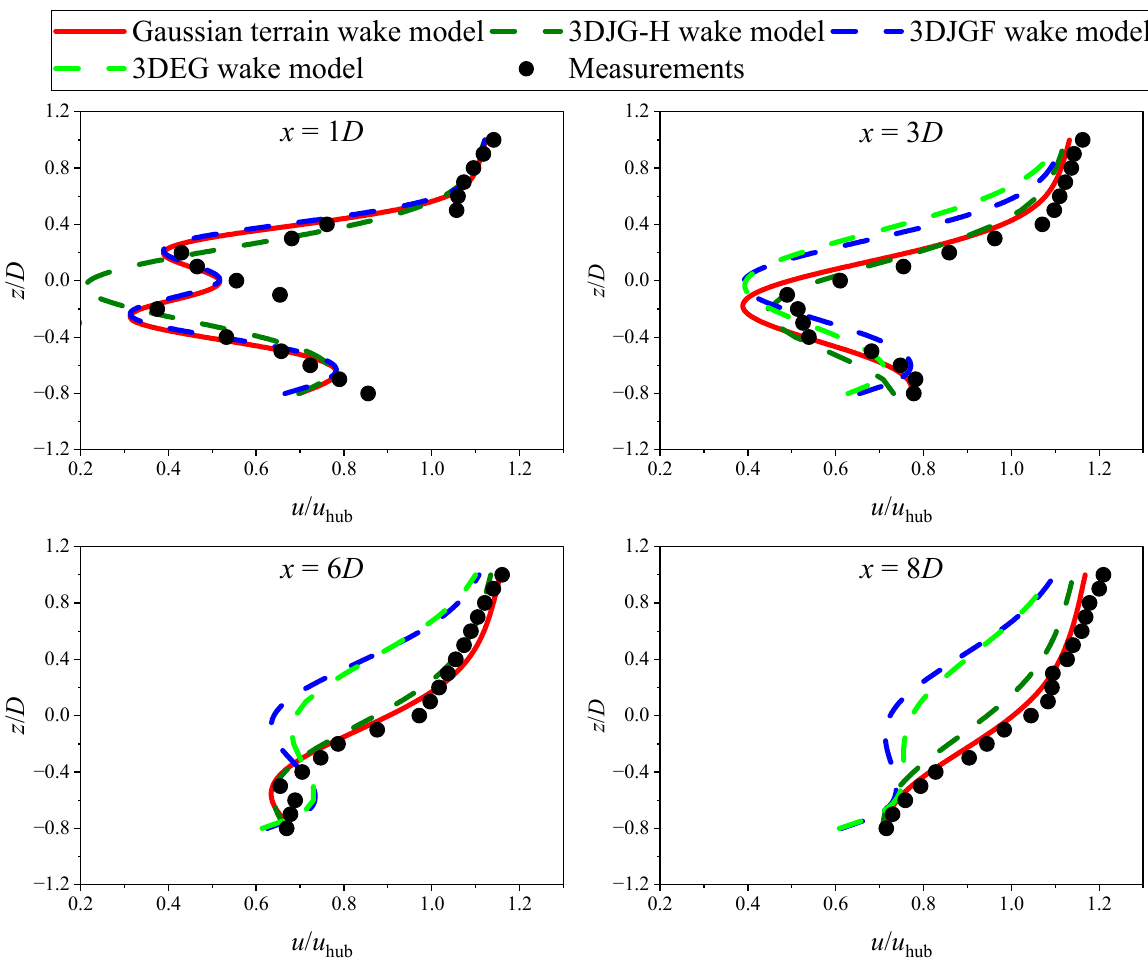
Figure 10. Comparison results of vertical profiles at four downstream locations.